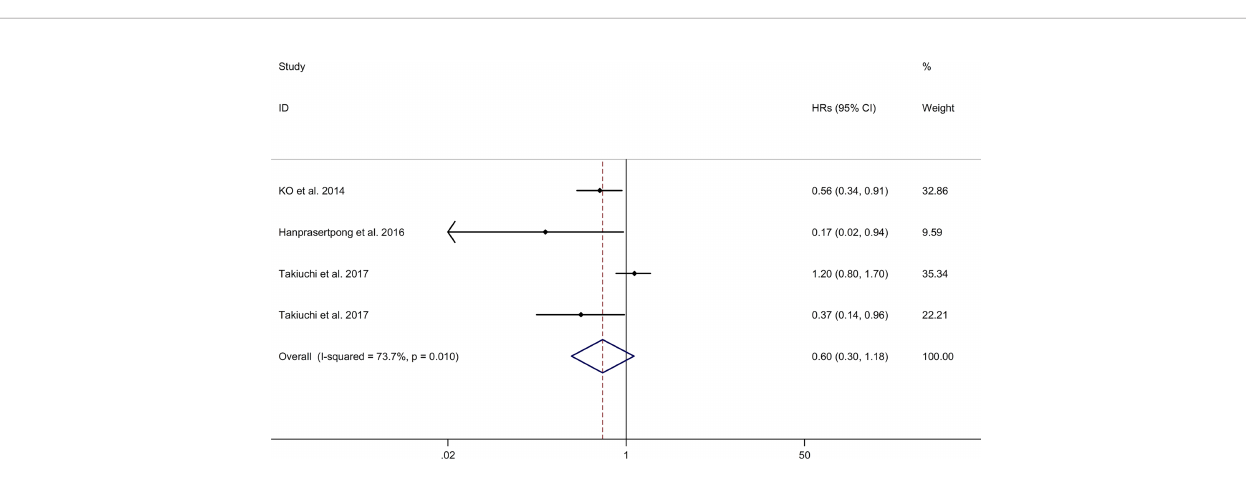
FIGURE 5 | Forest plots of association between metformin use and recurrence-free survival of gynecologic